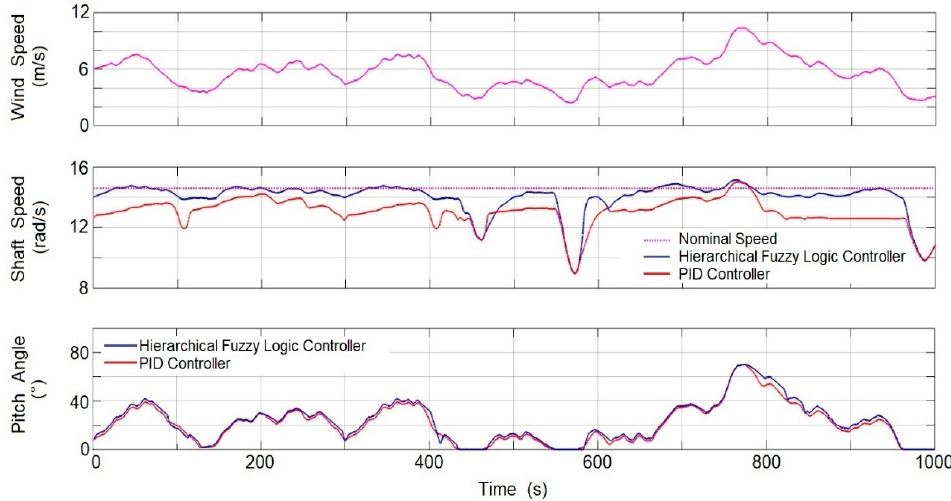
Figure 19. Experiment with real wind conditions. The behavior of the wind at the time of the experiment is shown in the upper part of the figure. The comparison of the generator shaft rotation speed using the HFLC and PID controllers is shown in the middle of the figure. The pitch angle movement with both controllers is shown in the lower part of the